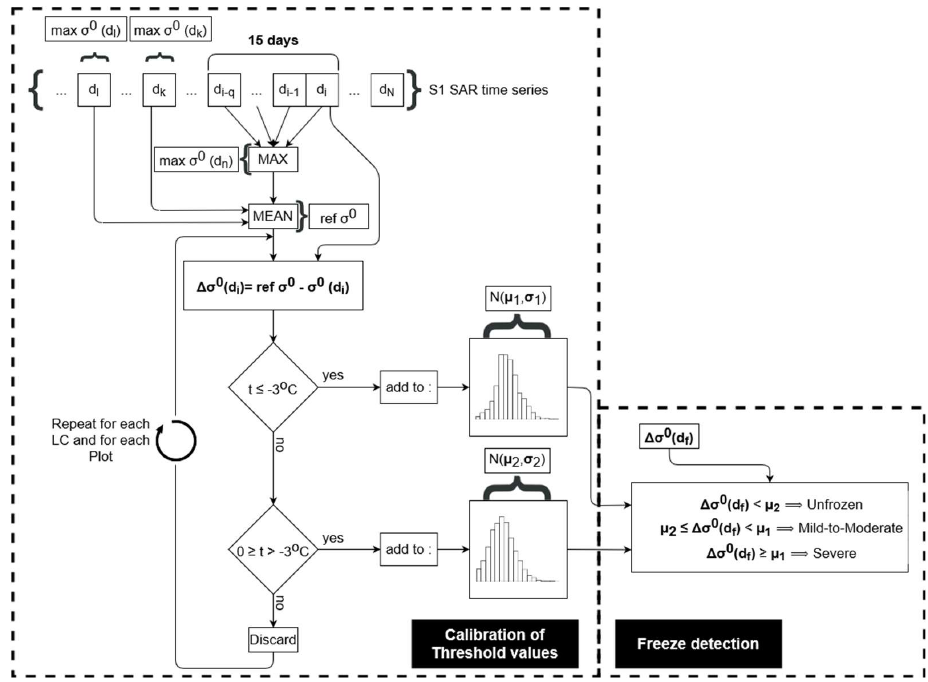
Figure 3. Repeat cycle of the Sentinel-1 synthetic aperture radar (SAR) images in ascending “A” (afternoon, red) and descending “D” (morning, blue) modes for the month of October 2018: ( a ) study site A, and ( b ) study site B. The number next to each line represents the incidence angle for each acquisition.